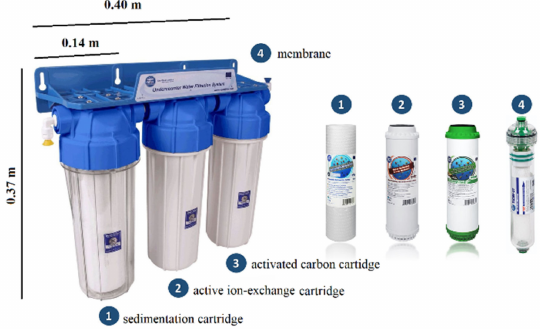
Figure 1. Tap water filtration set [33].